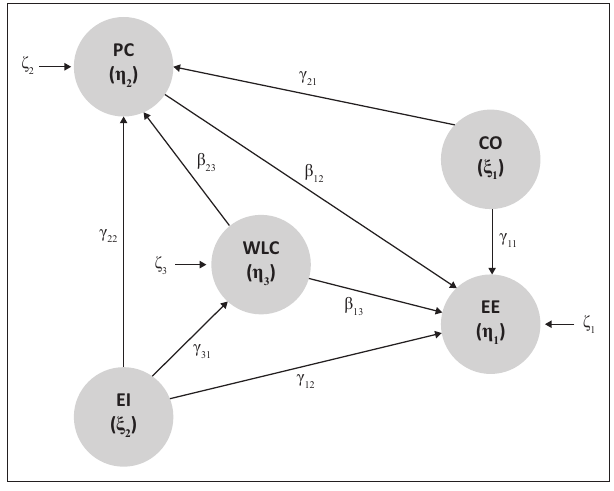
FIGURE 1: Proposed personal resources and employee engagement structural